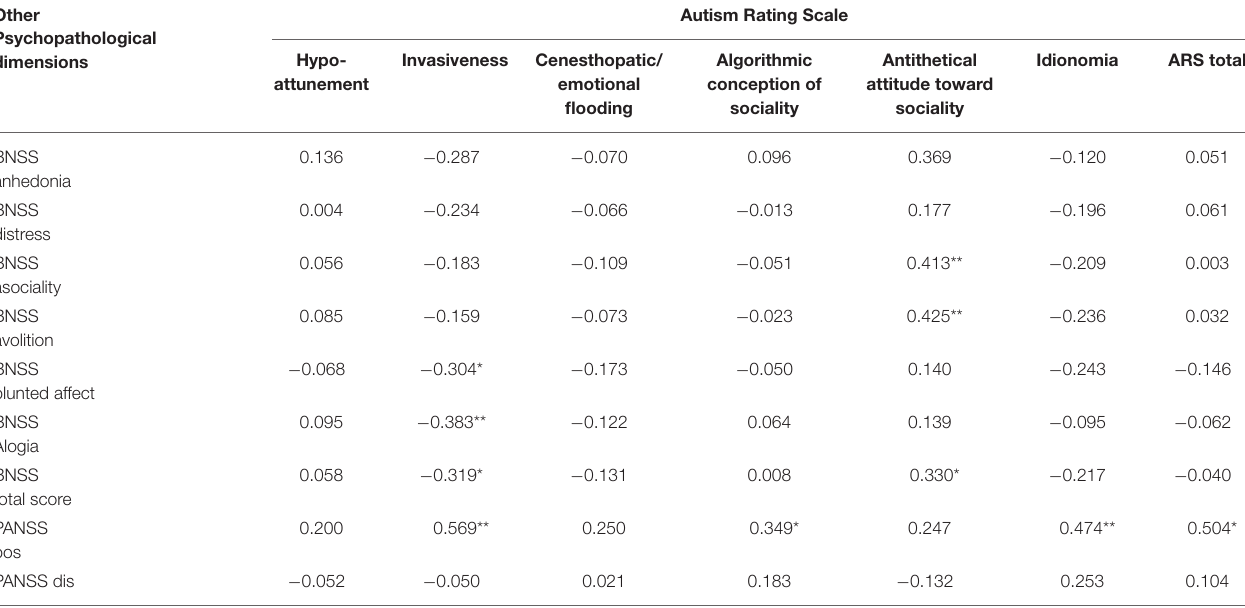
TABLE 3 | Correlations of Autism Rating Scale total and dimensions scores with other psychopathological dimensions.